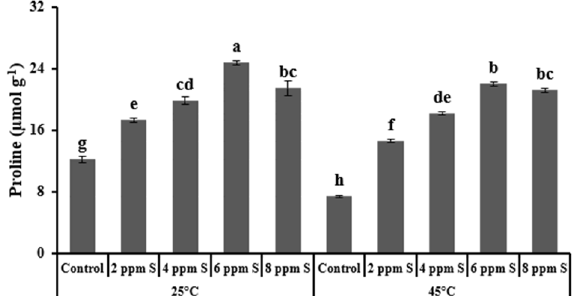
Figure 3. Proline contents of tomato plants (cv. Roma) as affected by temperature and exogenous application of S. Same letters indicate non-significant differences among treatments according to Tukey’s honestly significant difference test ( p ≤ 0.05). Vertical bars indicate averages ± standard errors ( n = 4, 5 plants per replicate).